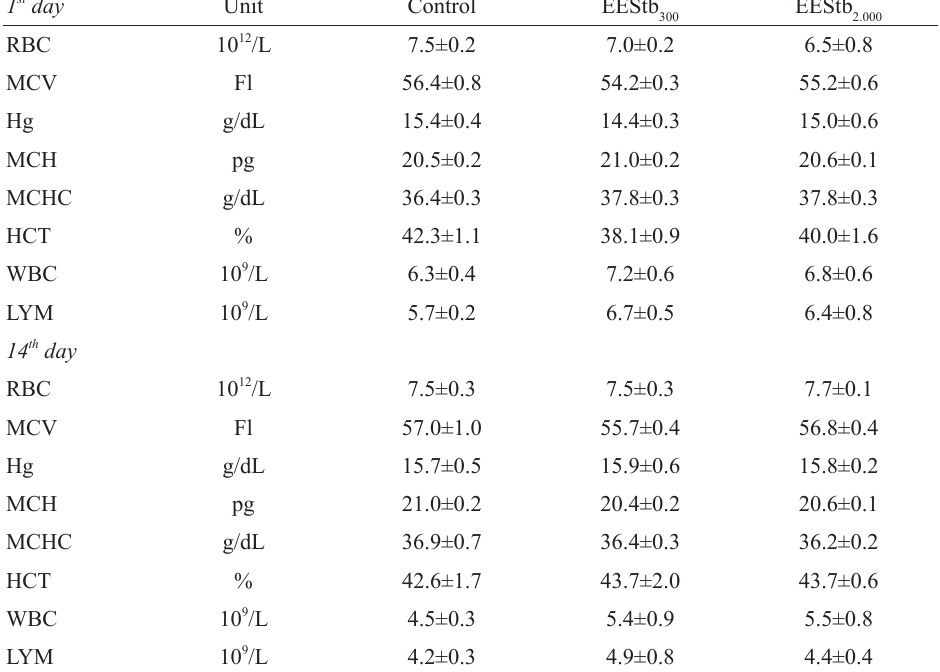
Effects of acute oral treatment with the EEstb on hematological parameters of control (C),